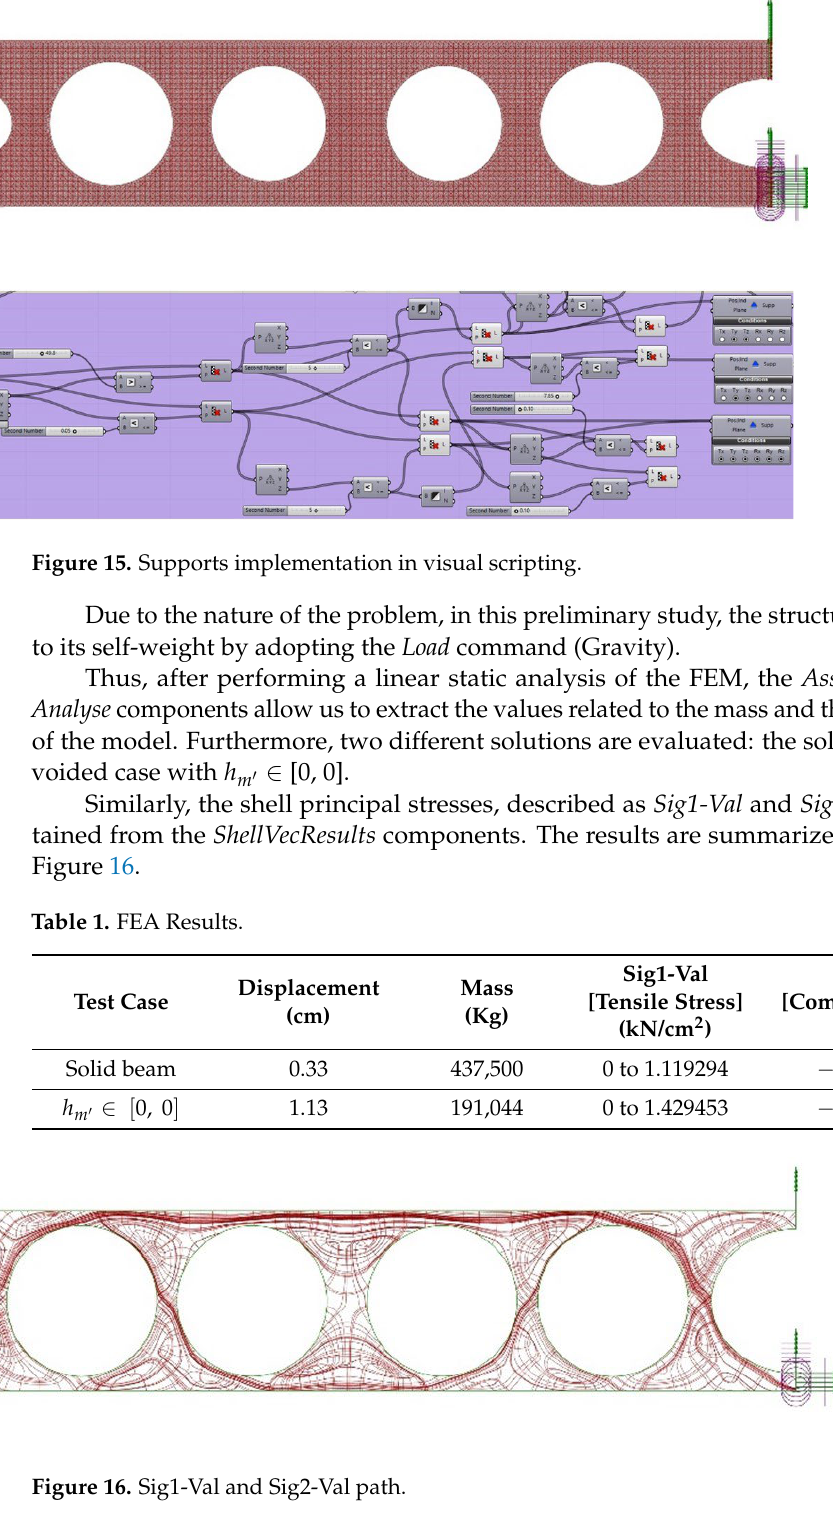
Figure 17. Tension (blue) (Sig1-Val) and compression (red) (Sig2-Val) path in the voided beam.